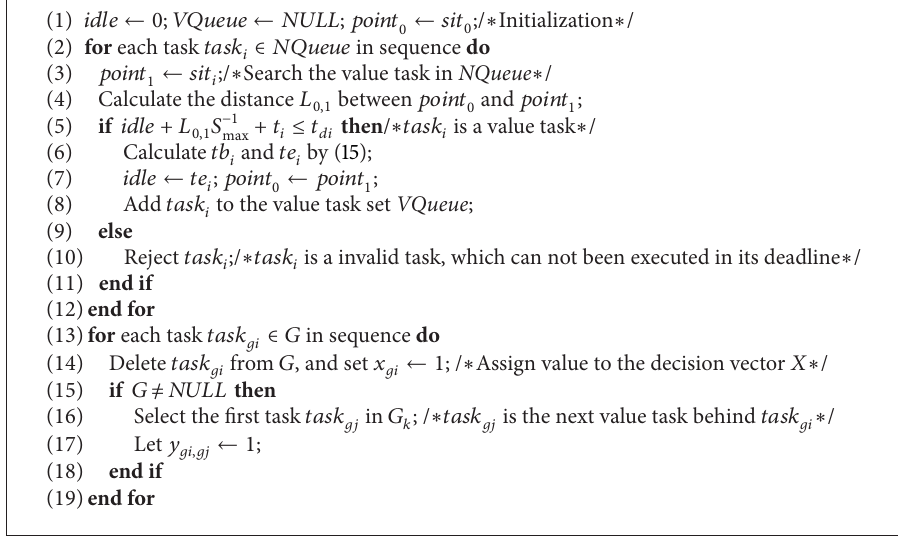
Algorithm 2: Pseudocode of VTD